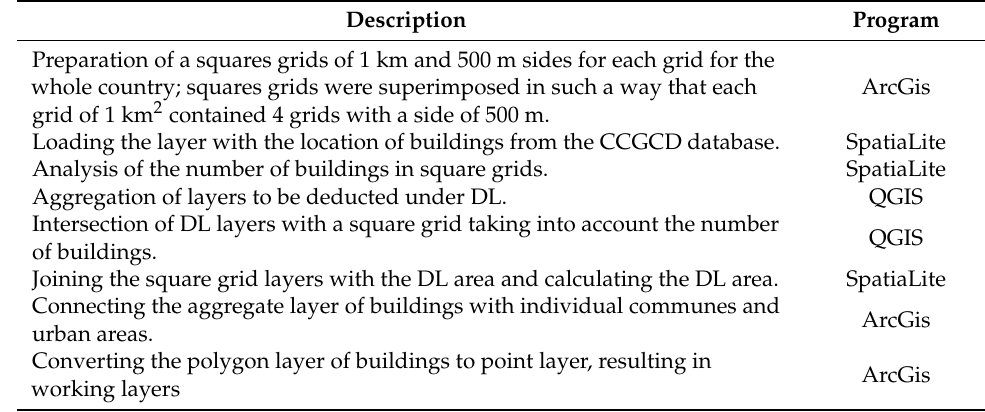
Table 2. Urban morphology indicators. Morphological